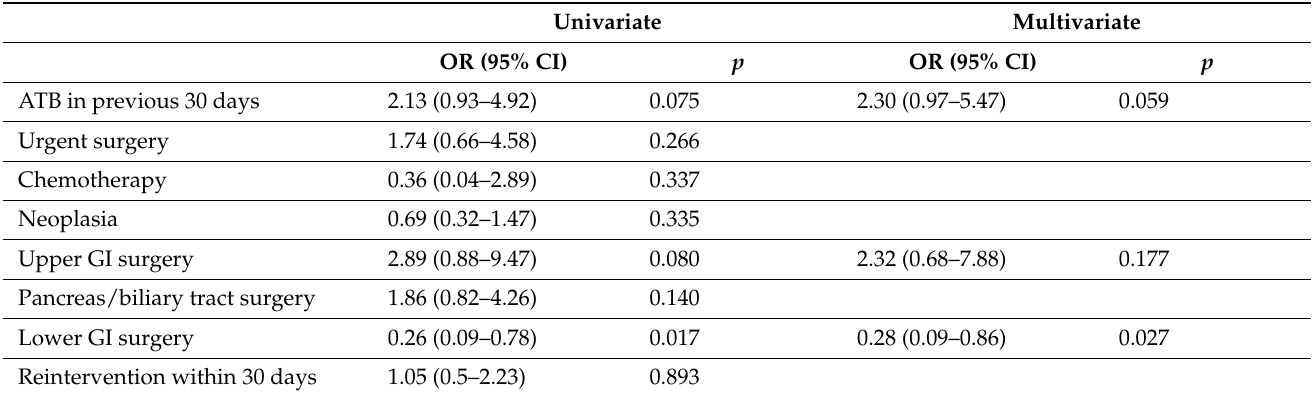
Table 4. Factors associated with Candida isolation from the abdomen when an intra-abdominal sample was available (n =